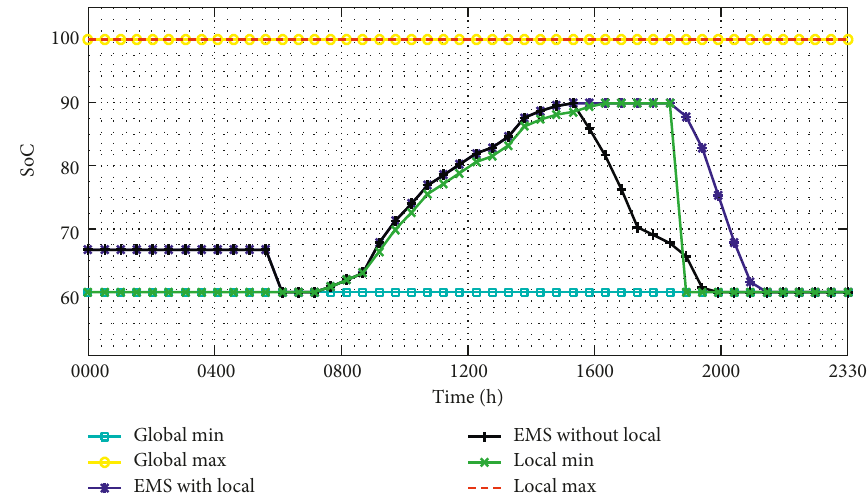
Figure 12: Battery SoC variation of the two systems alongside with battery local and global SoC